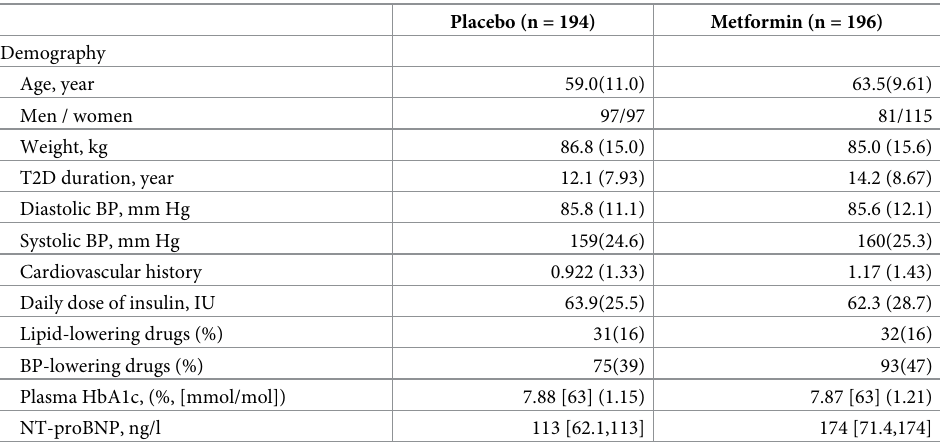
Table 1. Baseline characteristics.